Question: State the chart type depicted above.
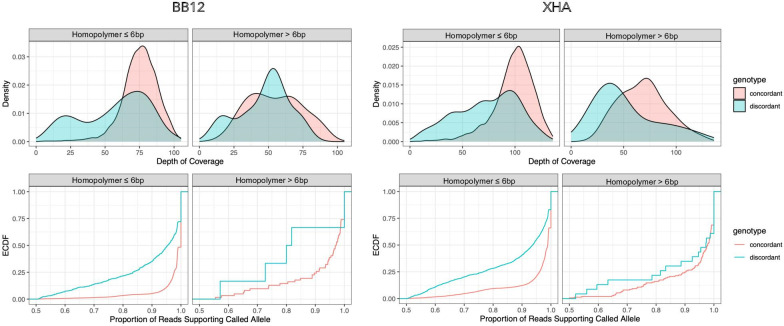
Answer: line